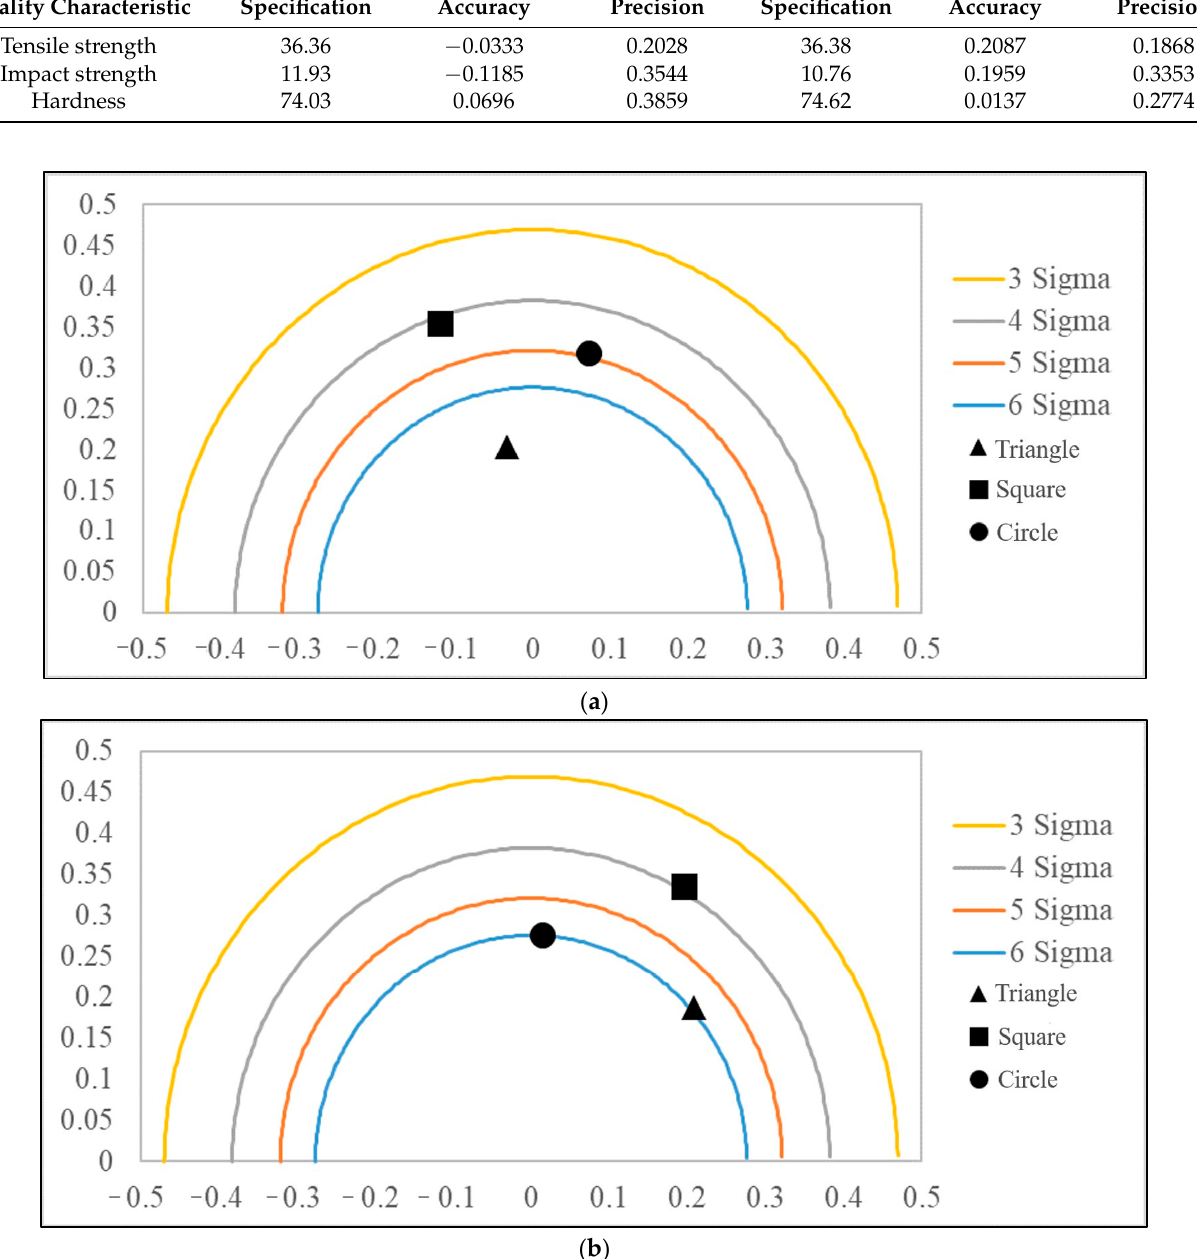
Figure 12. MPCAC/C pm of two types: ( a ) Cyclone type. ( b ) Screw